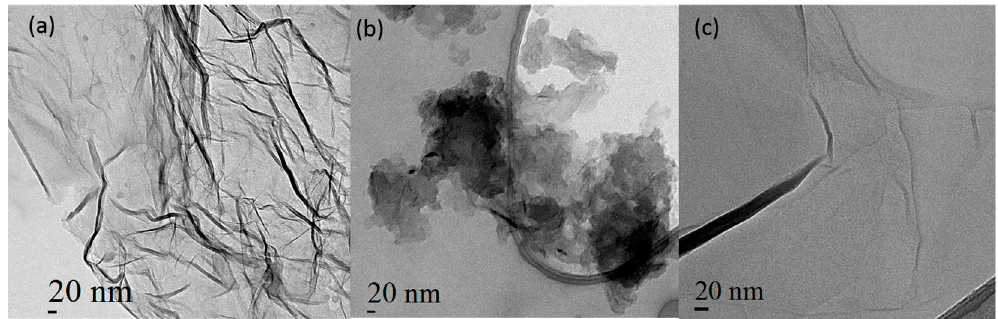
Figure 2. TEM (transmission electron microscopy) images of: ( a ) graphene nanopowder (from Graphene Supermarket); ( b ) graphene nanoplatelet aggregates (from Strem Chemicals); and ( c ) reduced graphene oxide.